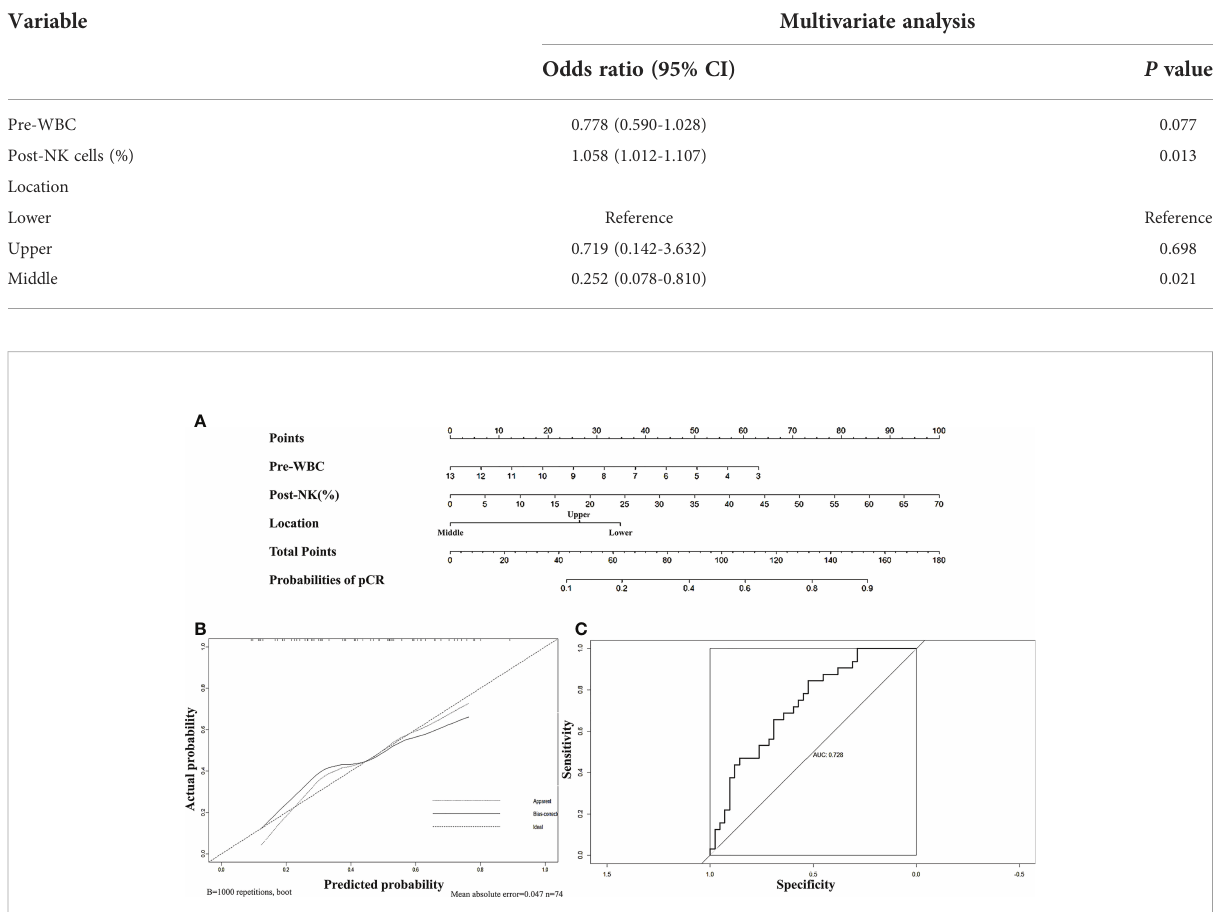
FIGURE 3 (A) Nomogram for predicting pCR rates after neoadjuvant chemoradiotherapy in patients with oesophageal squamous cell carcinoma. The nomogram adds up the points identi fi ed on the scale for each independent factor. The total scores projected on the bottom scale indicate the probabilities of pCR. (B) Calibration plots of the nomograms. (C) ROC curves of the